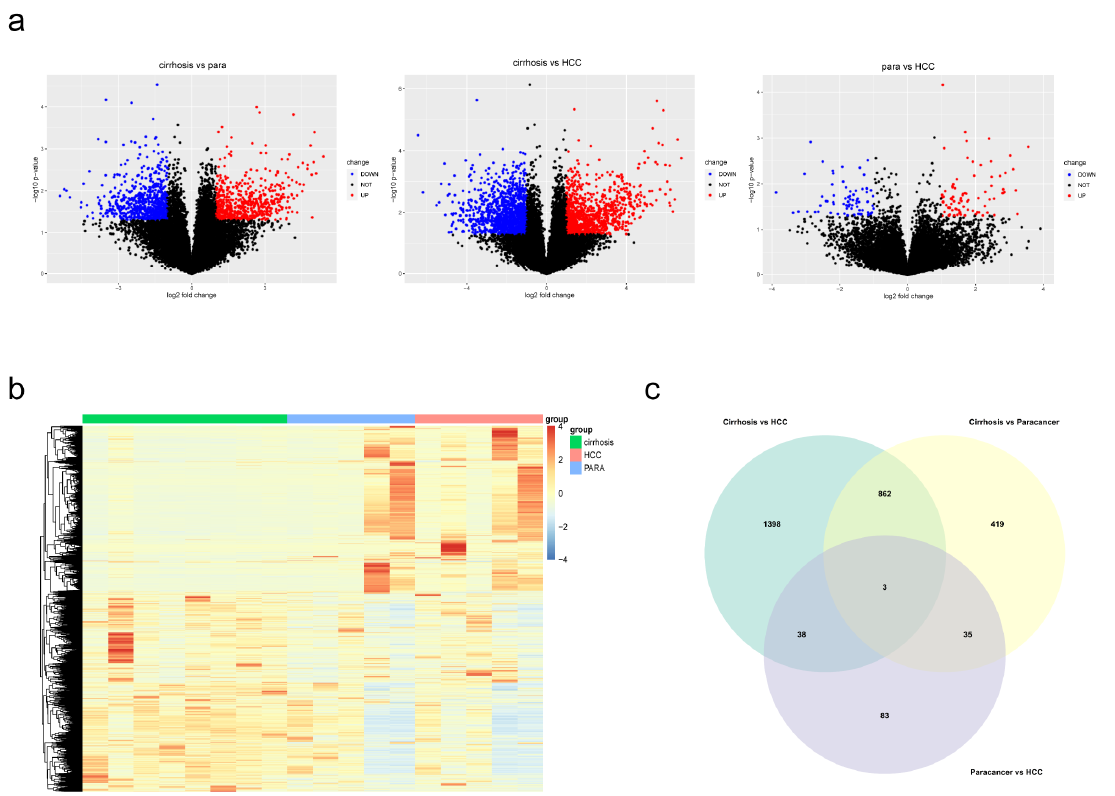
Figure 2. Identification of DEGs in the three comparisons. ( a ) Volcano plots revealed the DEGs between each comparison. ( b ) Heatmap of DEGs in cirrhosis, paracancerous tissues and HCC. ( c ) A Venn diagram revealed overall DEGs by combining three DEG sets.